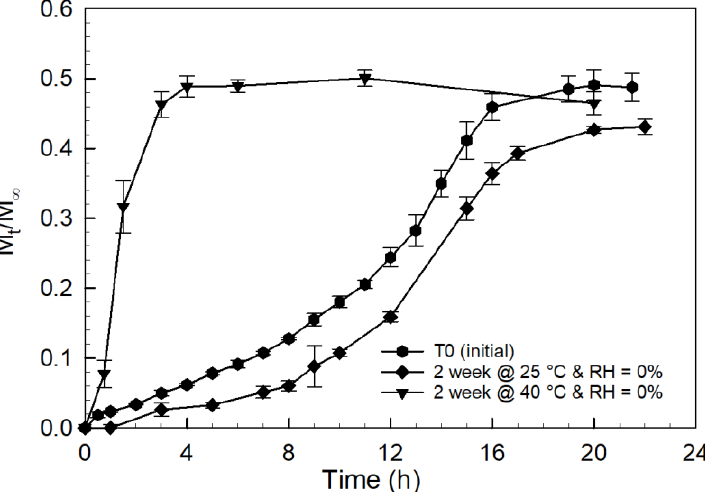
Figure 9. Curcumin release profiles for PCBAE prodrug tablets stored at 25 °C and 40 °C for 2 weeks in the absence of surrounding moisture with analysis using UV–Vis method.